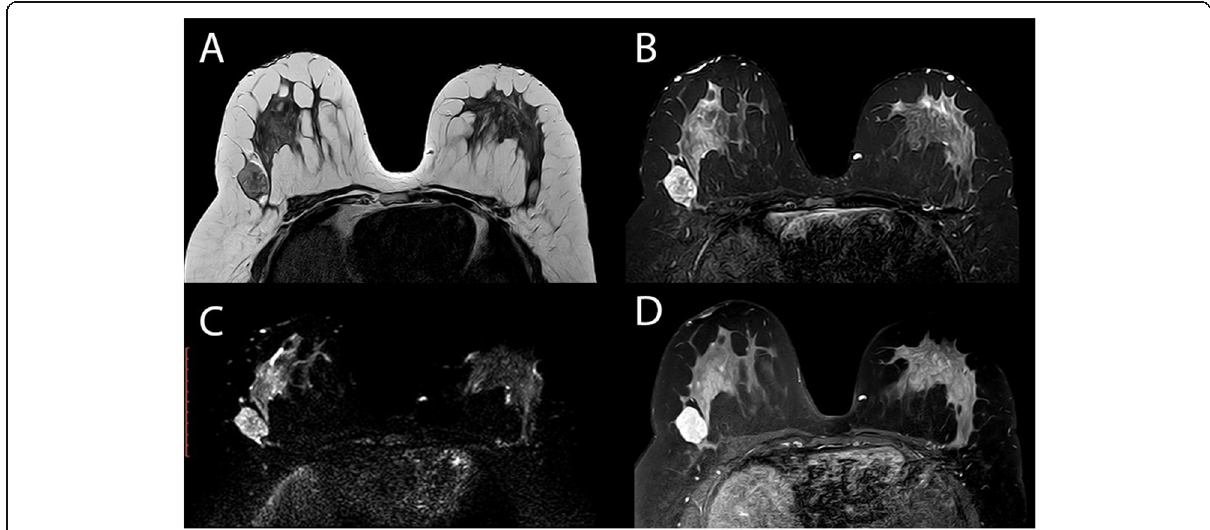
Fig. 1 A case of pathologically proven fibroadenoma in the right breast. It had a well-defined regular margin and of low T1 SI, high SI in T2WI ( a ) and STIR ( b ), and restricted diffusion in DWI ( c ). ADC value was 1.39 × 10 − 3 mm 2 /s. It exhibited homogenous contrast enhancement in